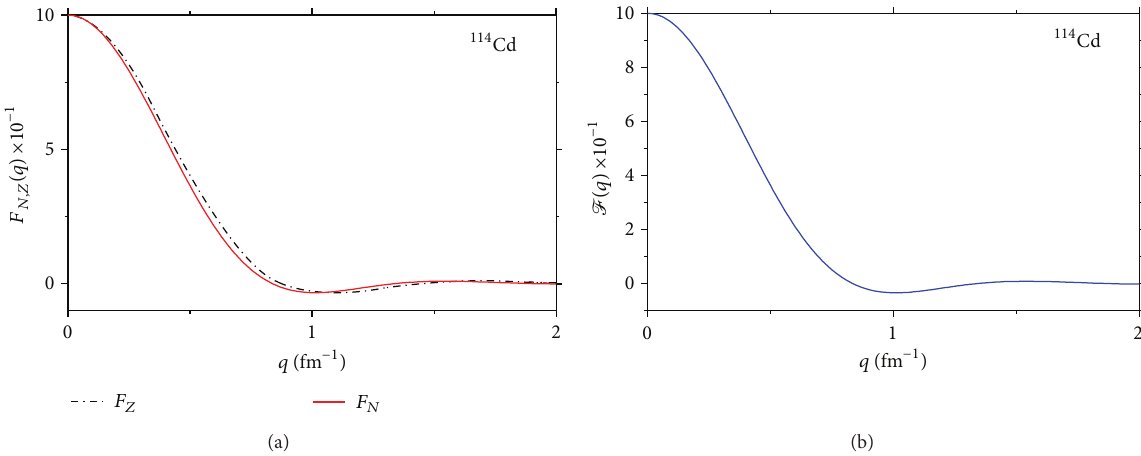
Figure 1: (a) Form factor F 𝑁,𝑍 (𝑞 2 ) (for neutrons and protons) for 114 Cd isotope. (b) The ground state elastic nuclear form factor 𝐹(𝑞 2 ) .